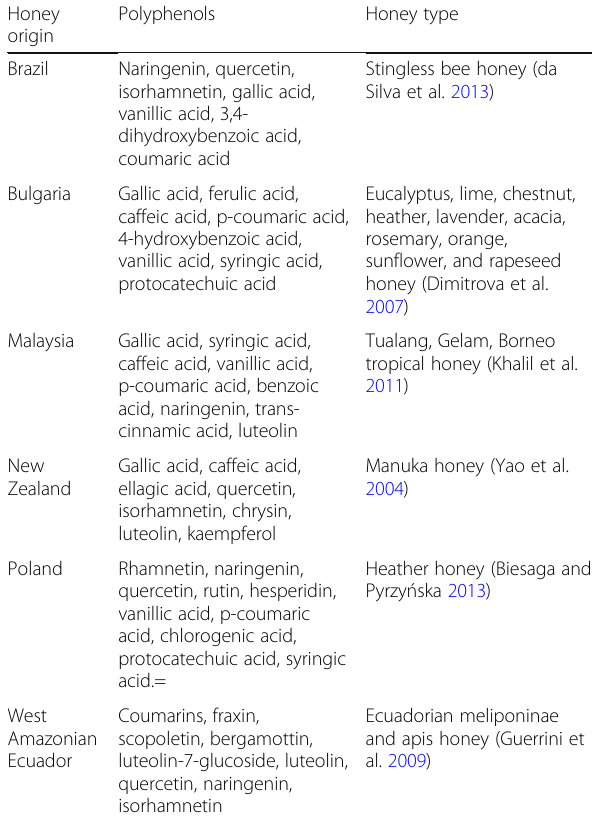
Table 2 The bioactive flavonoid and phenolic acid compounds found in